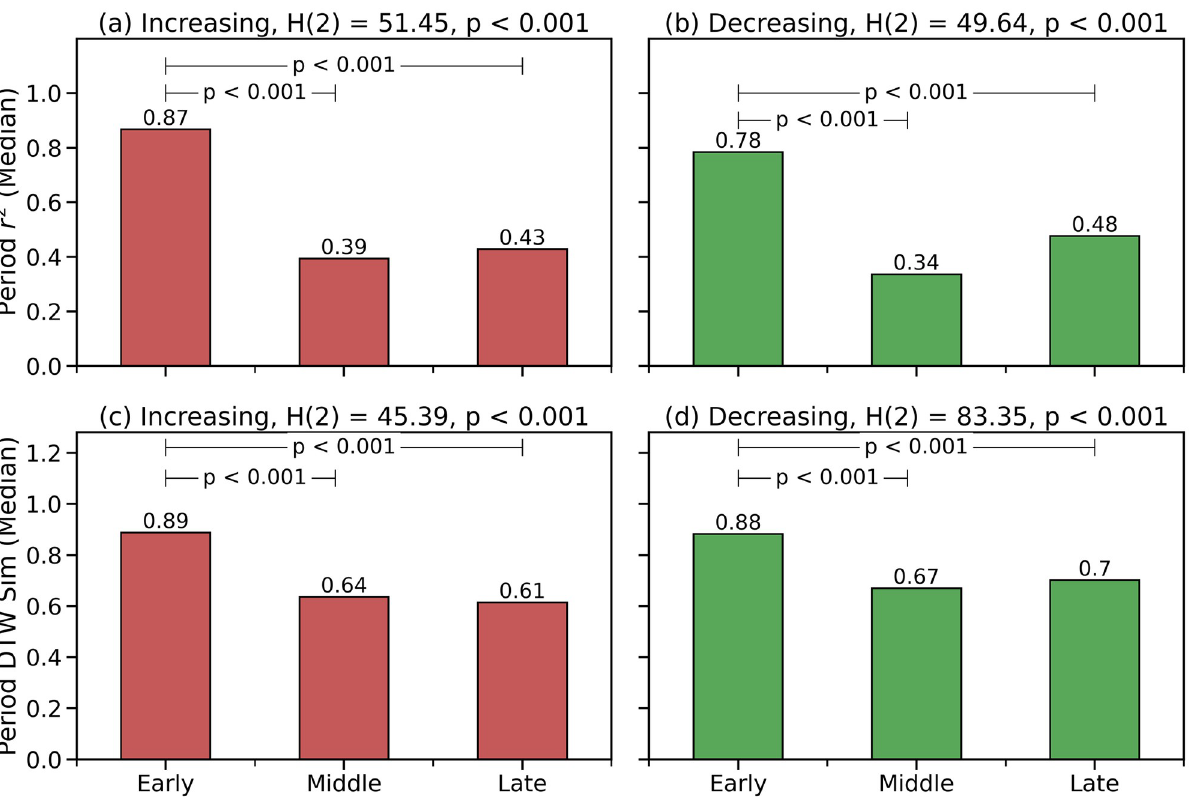
Fig 4. The results of a Kruskal Wallis test comparing thevarious adherence metrics, during increasing and decreasing periods, by pandemic phase are shown as the title of each graph: The H and p values are provided along with the degrees of freedom shown for each H value in brackets. The p values for the subsequent post hoc Dunn’s test are shown as horizontal lines connecting the periods for which there is a significant difference in adherence metric value, with the corresponding p value threshold indicated.